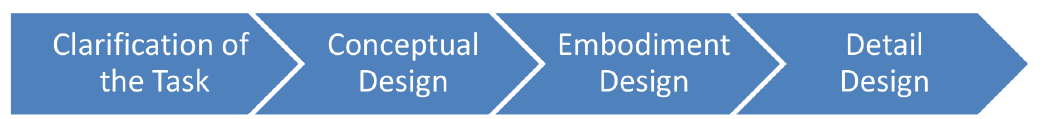
Figure 2. The four phases of the systematic approach of Pahl and Beitz